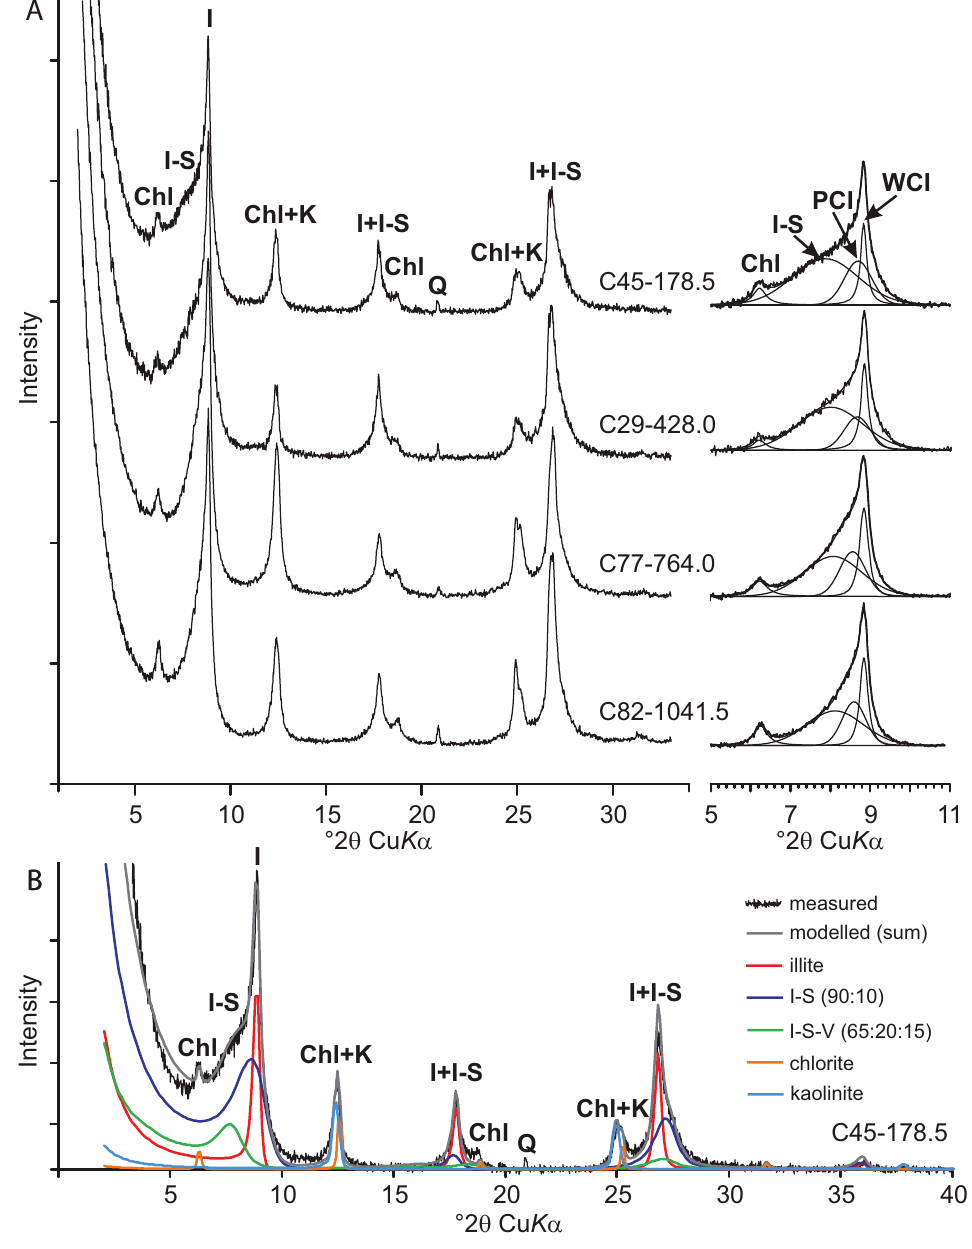
Fig. 2. Representative XRD patterns of the <2 μm fraction. A , in air­dry state, and the same patterns after background stripping and decomposition in the 5–11 °2θ (Cu K α) region; B , MLM2C and MLM3C modelled clay mineral composition of C45 sample. Chl, chlorite; I, illite; I­S, illite­smectite mixed­layer mineral; I­S­V, 3­component illite­smectite­vermiculite mixed­layer mineral; K, kaolinite; PCI, poorly crystalline illite (illitic illite­smectite); Q, quartz; WCI, well­crystalline illite and/or detrital